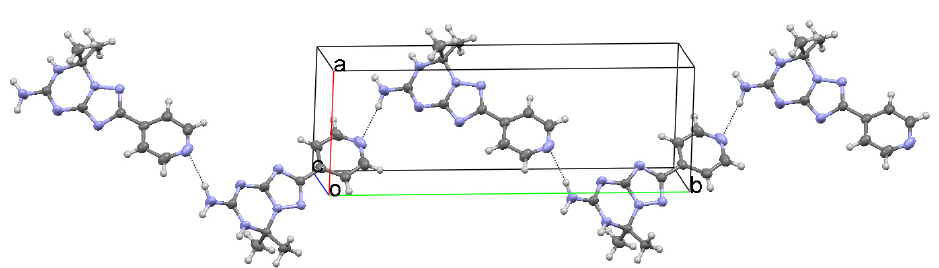
Figure 4. A view of the crystal packing in 1 along the c axis, showing the C (11) chain of molecules formed by the NH···N hydrogen bonds running parallel to the [010] direction.